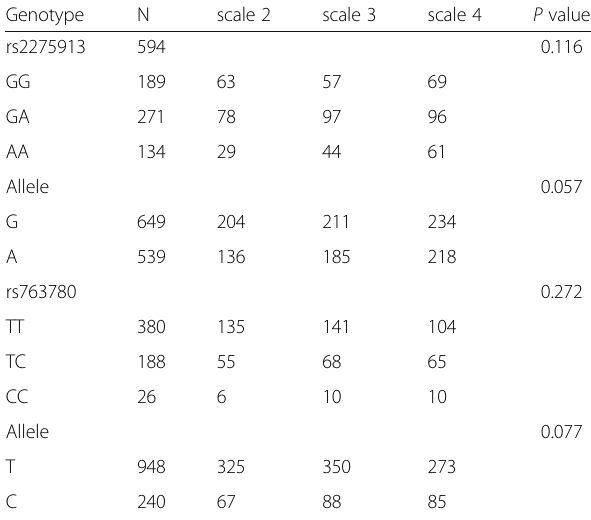
Table 3 The association of different genotypes and alleles of various polymorphisms with the severity of knee OA